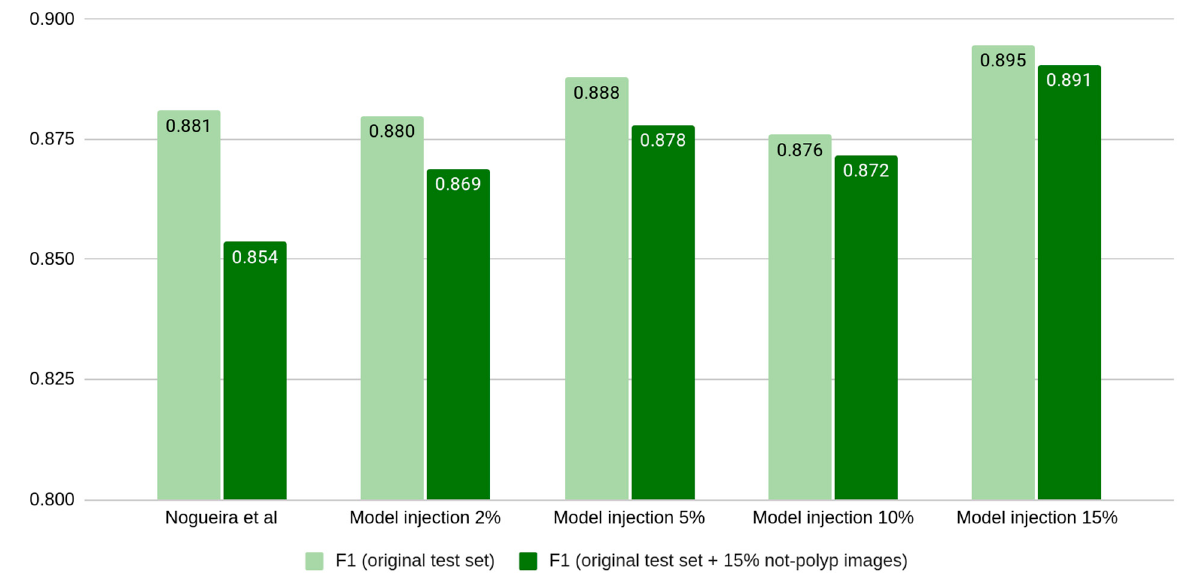
Figure 4. F1 of the five trained models in both the original test partition (light green) and the same with the addition of 15% of not-polyp images (dark green) [11].